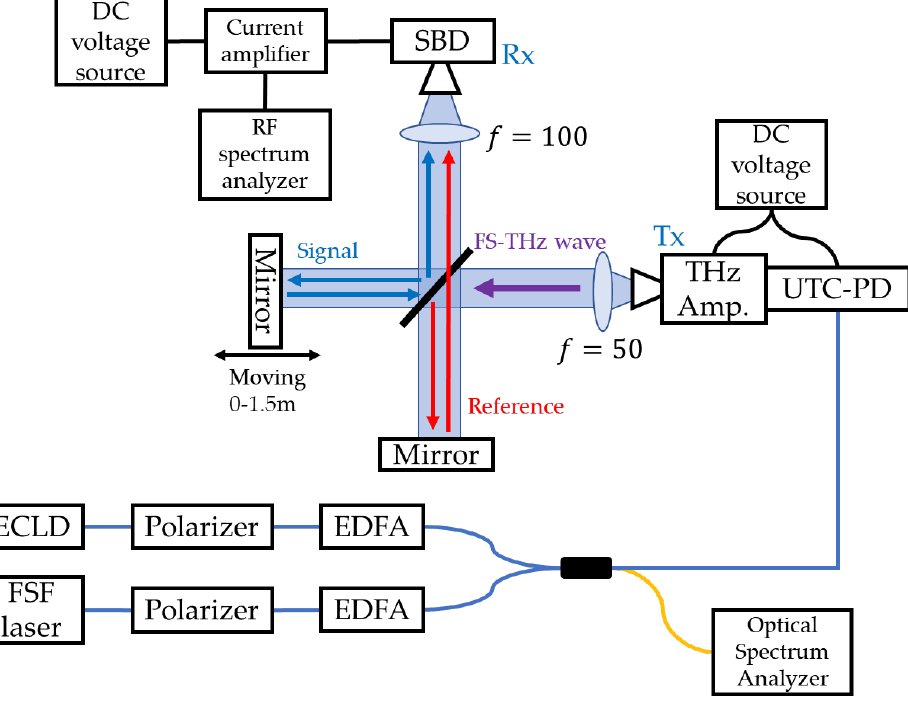
Figure 5. Experimental system of distance measurements using FS-THz waves.